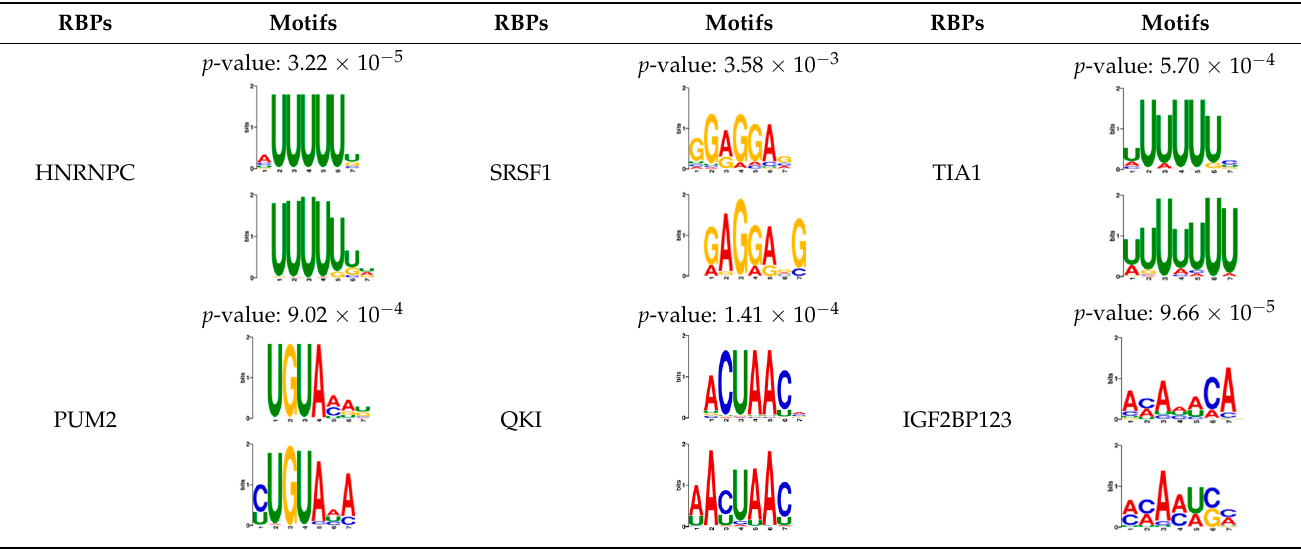
Table 4. Comparison of motifs extracted by HPNet (bottom) and motifs in the CISBP-RNA database (top). RBPs